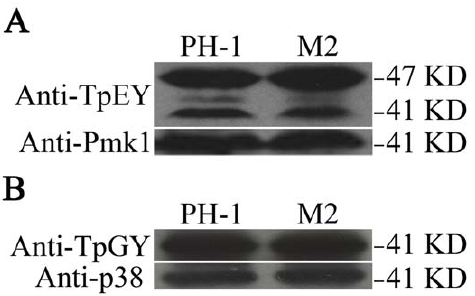
Figure 9. MAP kinase phosphorylation assays. Total proteins were isolated from the wild-type (PH-1) and amt1 mutant (M2) strains. When detected with an anti-TpEY antibody, the phosphorylation levels of Mgv1 had no significant changes in the amt1 mutant in comparison with the wild type. The phosphorylation of FgHog1 detected with an anti-TpGY antibody also appeared to be normal in the amt1 mutant. Detection with a monoclonal anti-actin antibody showed equal amount of